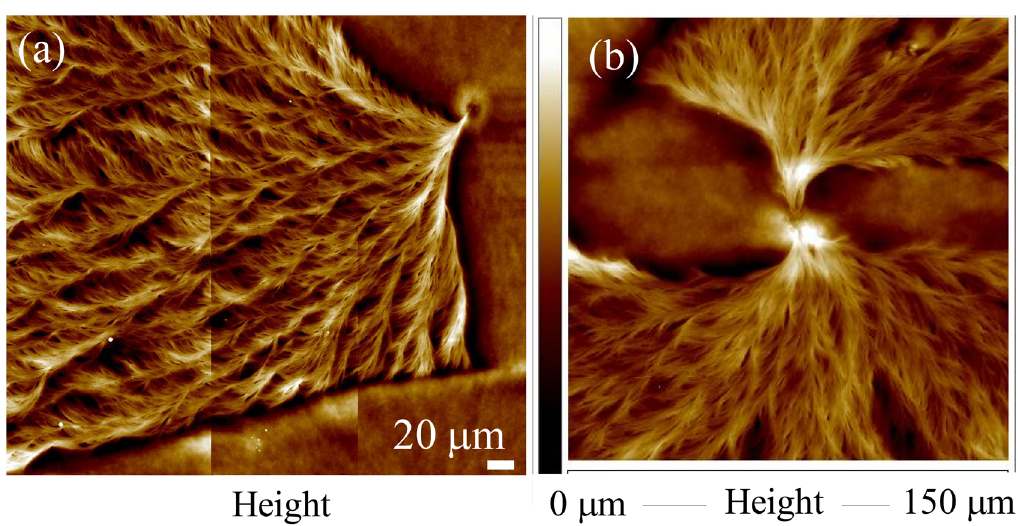
Figure 12. AFM height images for ( a ) single-spoke fan vs. ( b ) three-spoke fans in sector-face